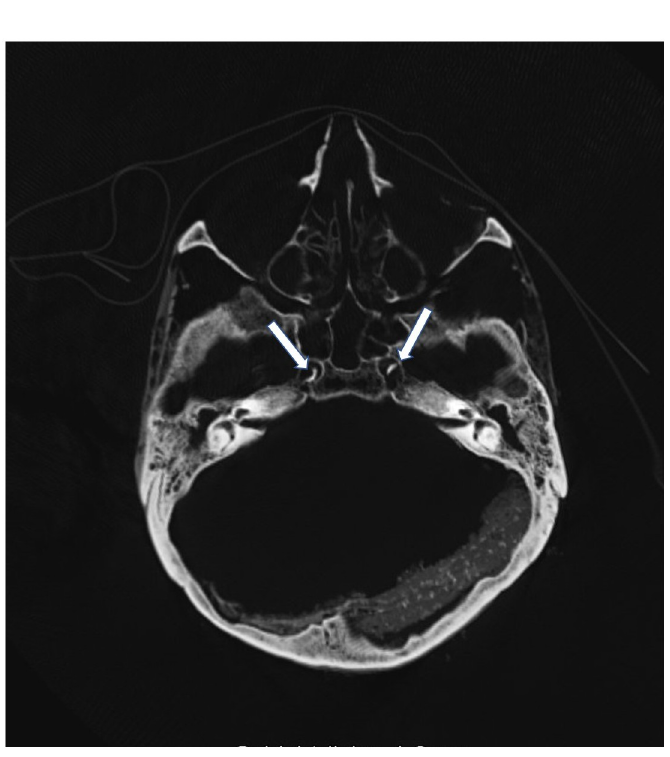
Fig 9. CT scan of the skull base showing bilateral calcifications of the internal carotid artery (arrows).